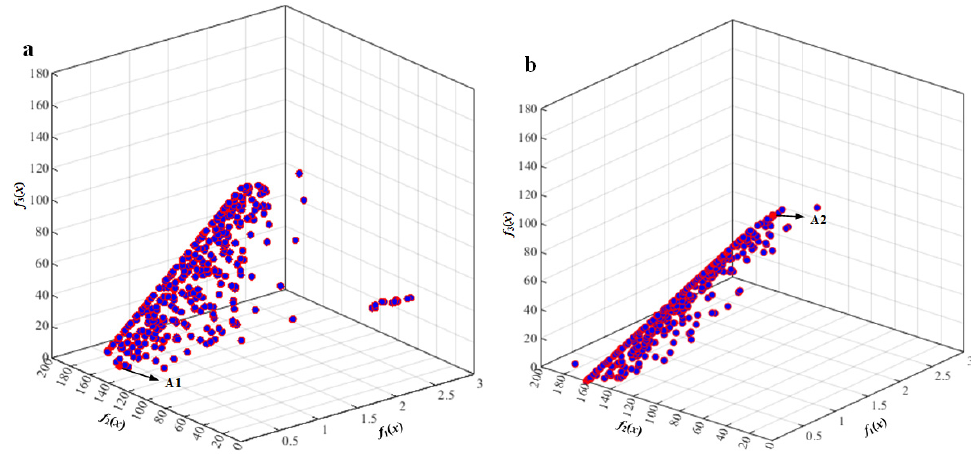
Figure 7. Pareto front obtained by tri-objective optimization using NSGA-III under engine rotation speed ω 1 = 170 Hz: ( a ) the optimal solution A1; ( b ) the optimal solution A2.